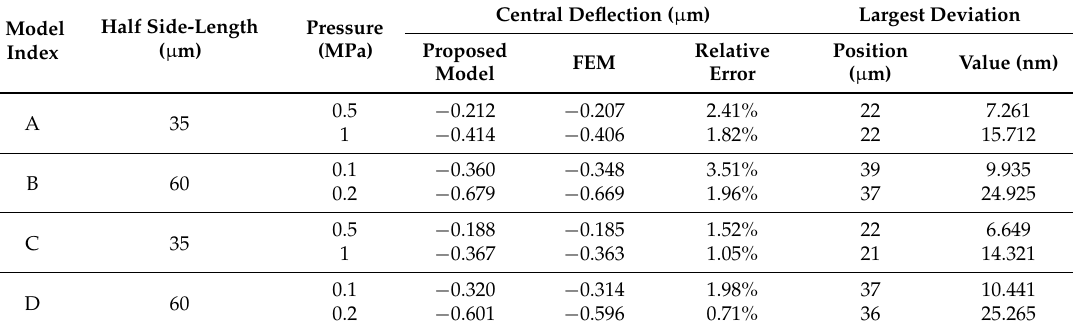
Table 3. Static deflection error analyses of three-layer CMUT membranes for different external